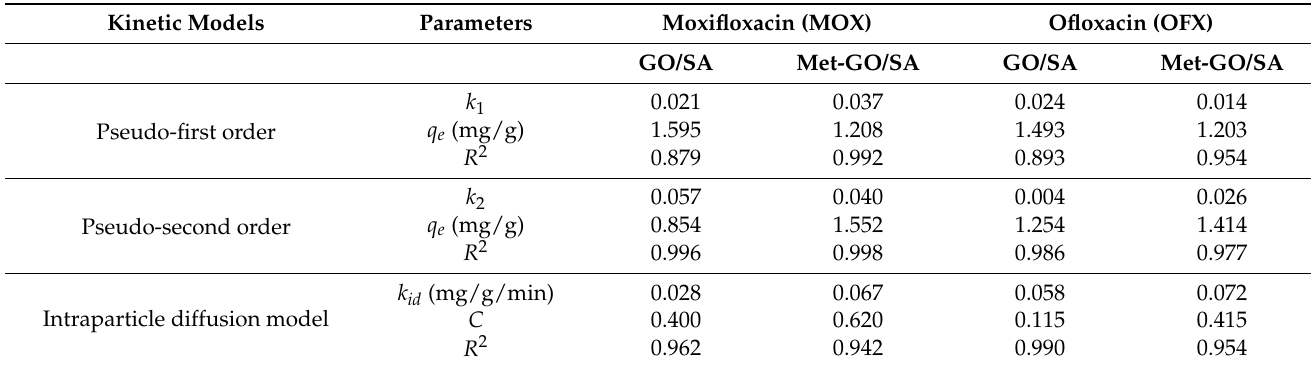
Table 4. Fitting parameters for MOX and OFX adsorption on functionalized (Met-GO/SA) and non-functionalized (GO/SA) using pseudo-first order, pseudo-second order and intraparticle diffusion models.